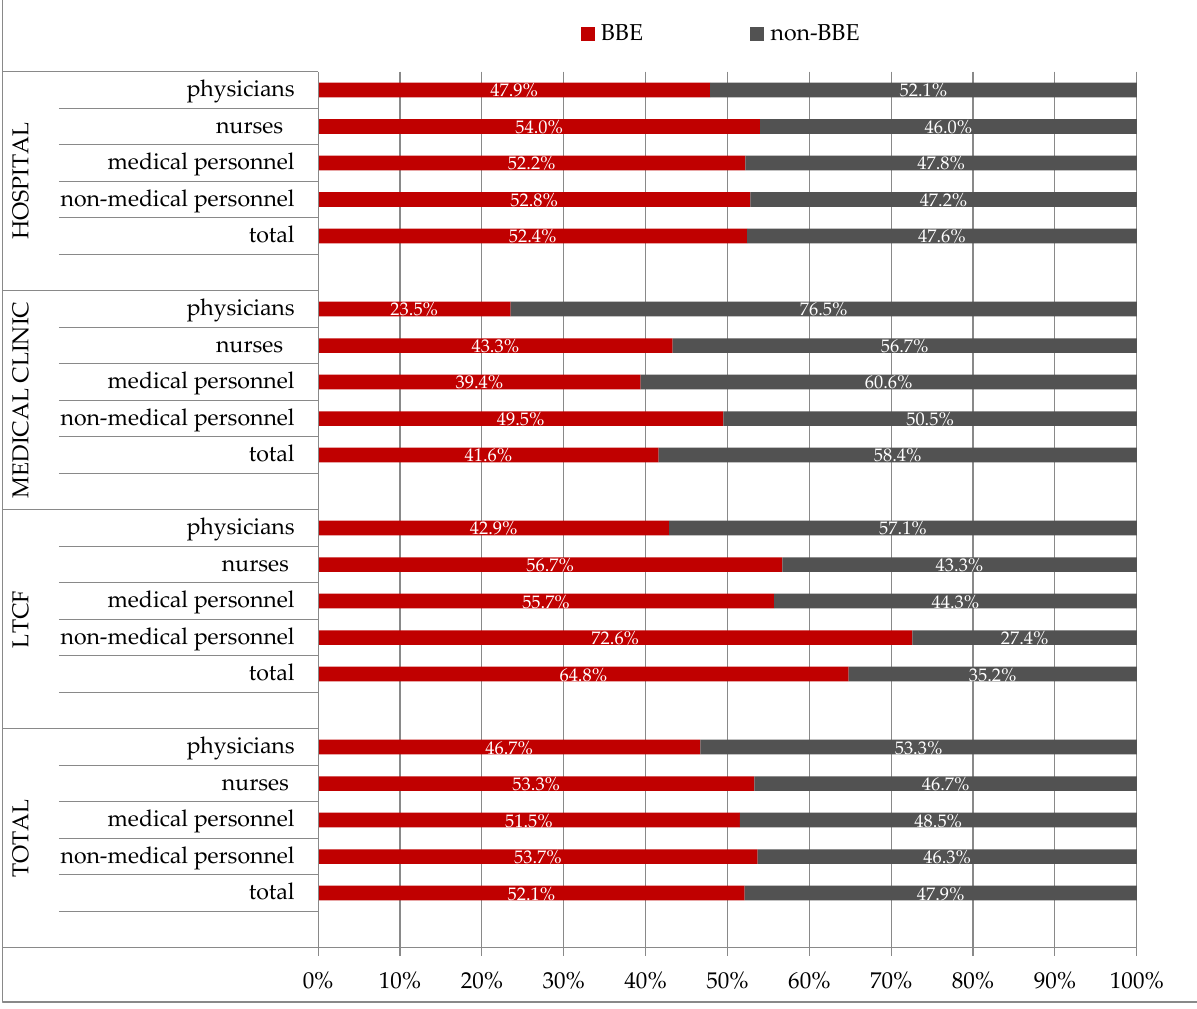
Figure 1. The frequency of adherence to the BBE policy depends on the person’s profession and place of work (LTCFs — long-term-care facilities).